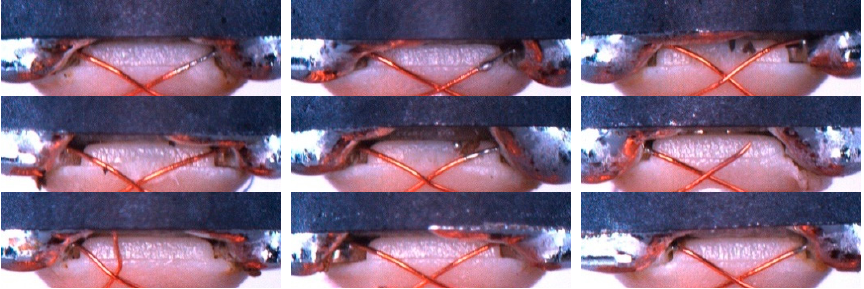
Figure 5. The ROC clipped from the original picture makes the proportion of defective parts larger, thus making the network easier to train and optimize.